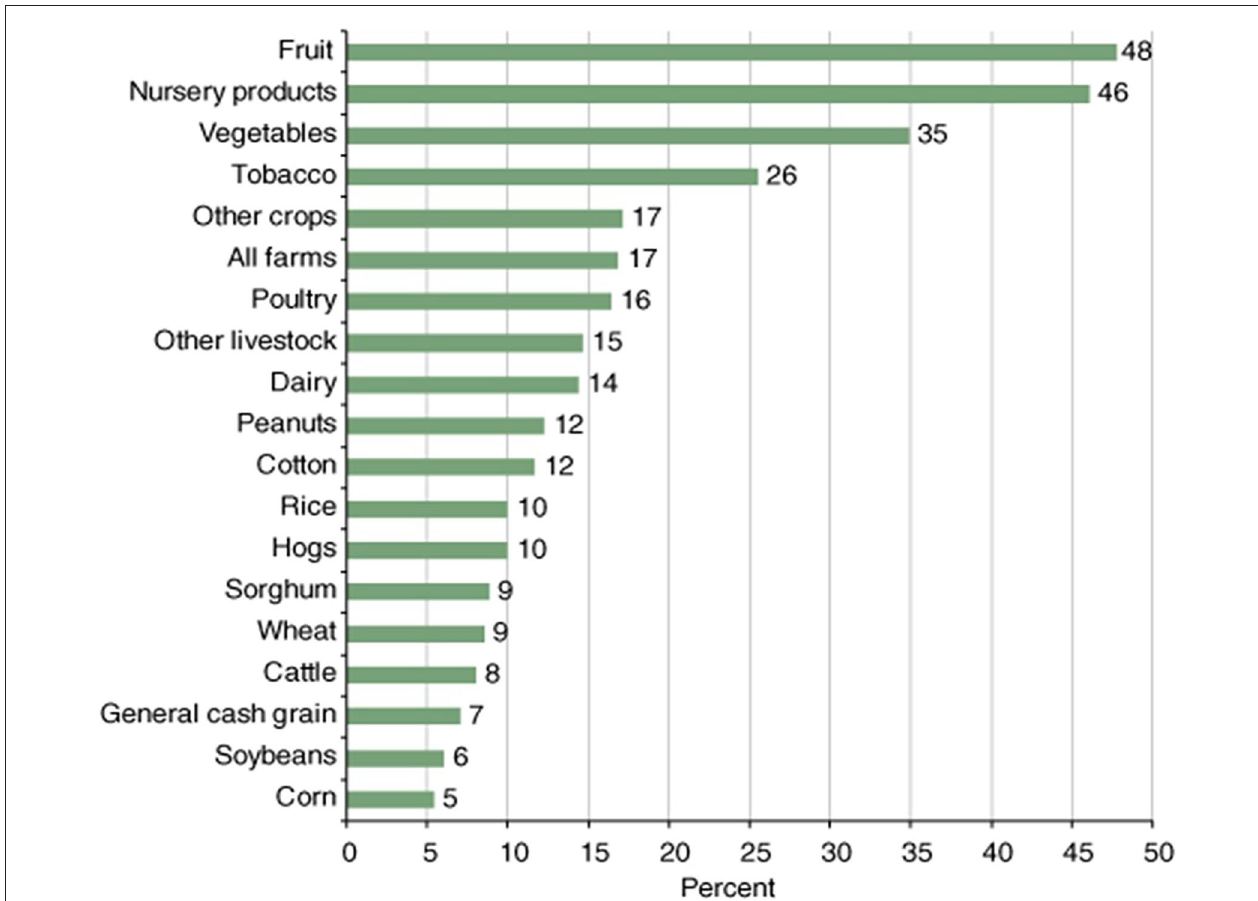
FIGURE 1 | Conmparison of hired labor costs as a share of production costs by farm